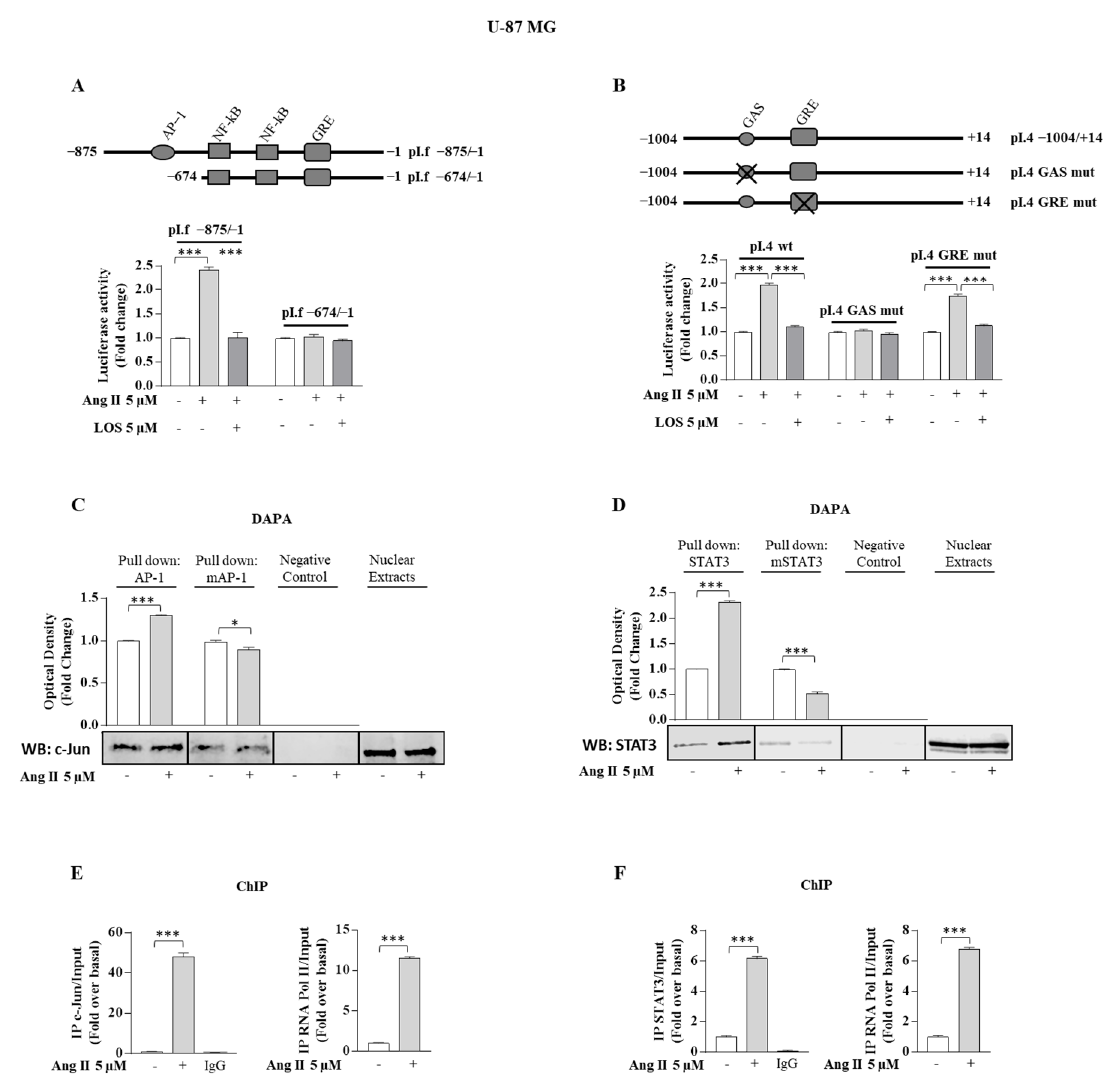
Figure 9. Aromatase promoters pI.f/I.4 in U-87 MG glioblastoma cells are stimulated upon Ang II exposure. ( A , B ) Upper panel, schematic map of the pI.f and pI.4 aromatase constructs. U-87 MG glioblastoma cells were transiently transfected with the reported constructs and treated with vehicle (−) or Ang II 5 µM, alone or in combination with LOS 5 µM for 24 h. ( C , D ) U-87 MG glioblastoma cells were treated in the presence of vehicle (−) or Ang II 5 µM for 3 h. Nuclear extracts were incubated with a biotinylated oligonucleotide containing the AP-1 or AP-1 mutant site in the aromatase promoters pI.f (left panel) or with a biotinylated oligonucleotide containing the STAT3 or STAT3 mutant site in the aromatase promoters pI.4 (right panel) and subjected to DNA affinity precipitation assay. Specifically bound proteins were subjected to Western blotting analysis. The specificity of the binding was tested by loading the unbound fraction (Negative Control). U-87 MG glioblastoma cells nuclear extracts were used as positive control. The histograms represent the mean average ± SD of three separate experiments in which band intensities were evaluated in terms of optical density arbitrary unit and expressed as